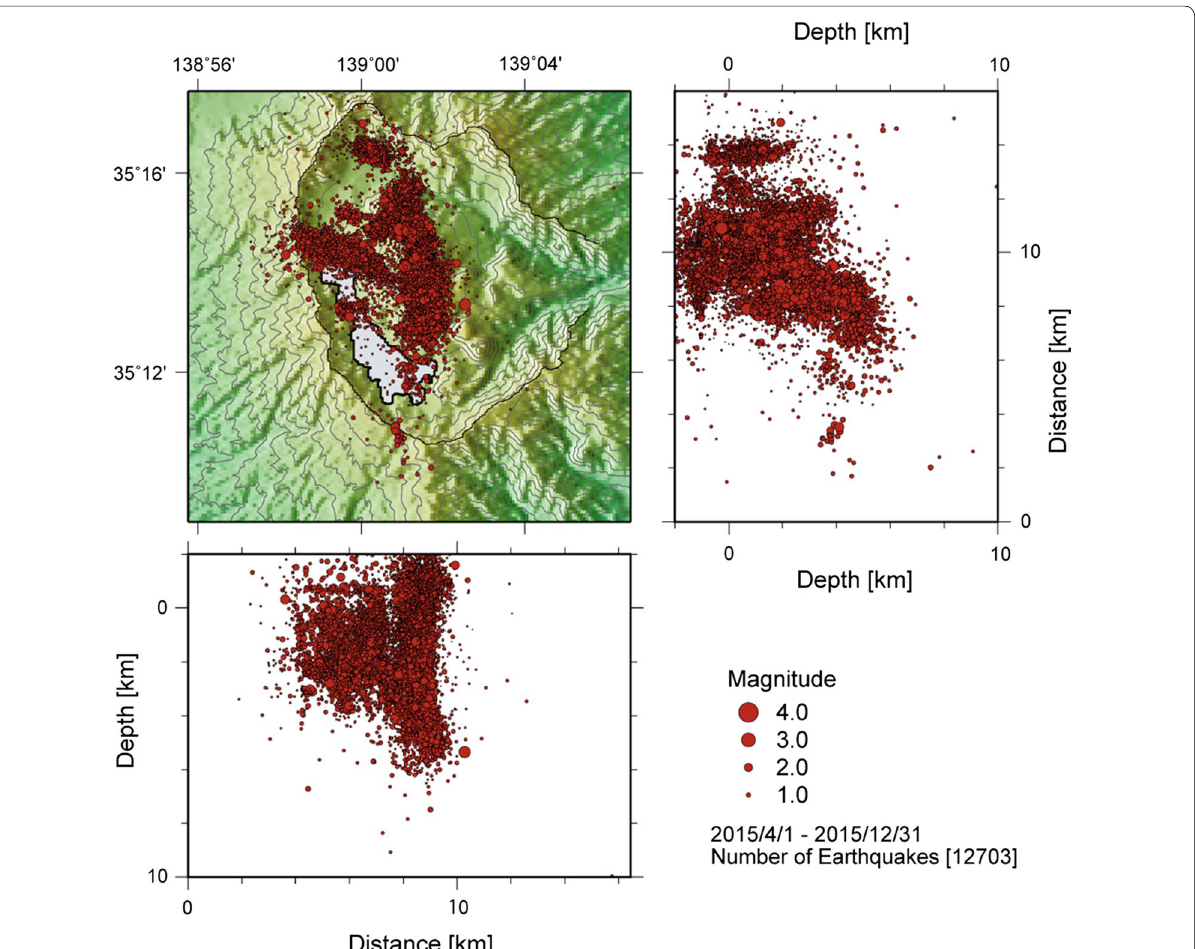
Fig. 2 Distribution of hypocenters in Hakone Volcano estimated by the routine analysis of the Hot Springs Research Institute of Kanagawa